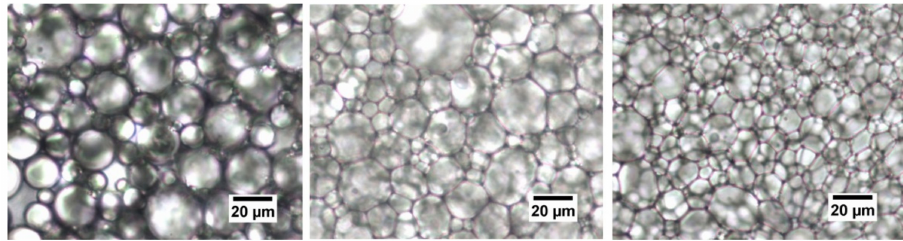
Figure 8. Emulsion with fresh milk with 65%, 70% and 73% oil (from left to right). The magnification is 40 × .